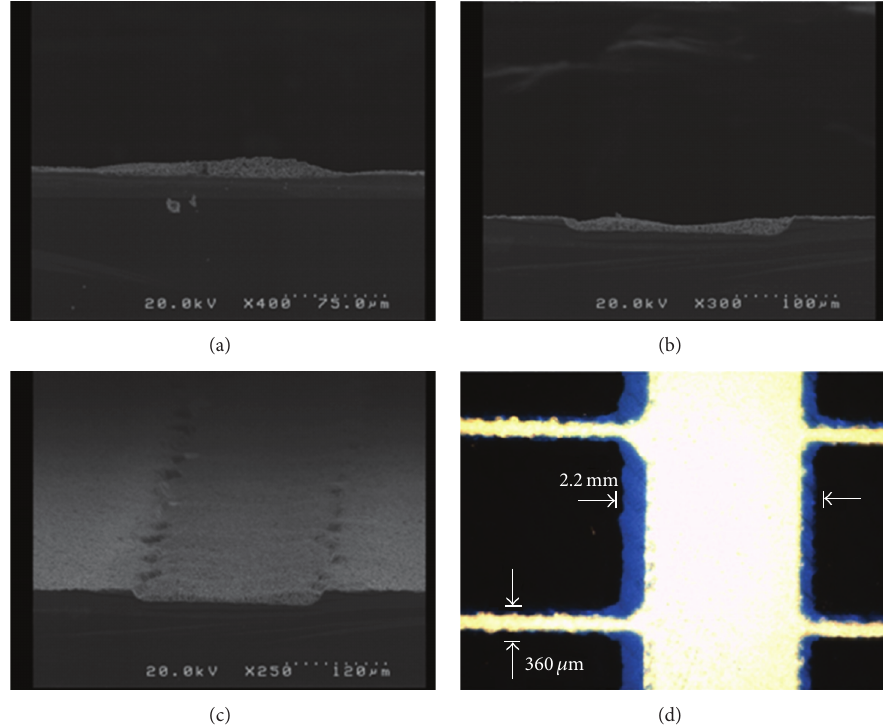
Figure 4: Cross-sectional SEM views for (a) a 2 𝜇 m deep trench and (b) a 15 𝜇 m deep trench, both being filled with silver paste. (c) is a prospective view for the silver-filled 15 𝜇 m deep trench, while (d) indicates the top view dimension for the busbar/gridline pattern.